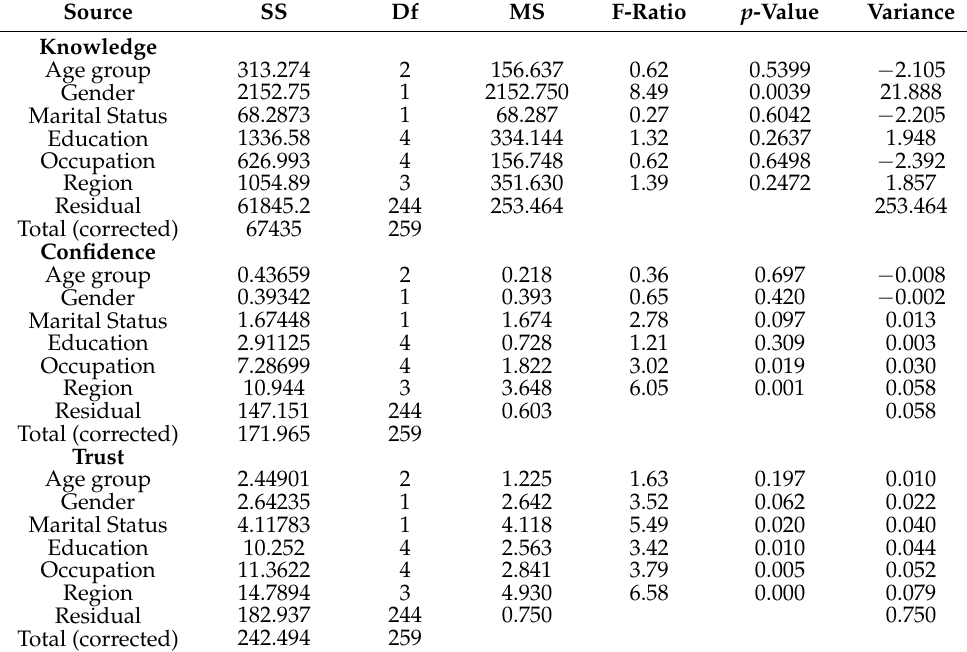
Table 5. Regression model outcome summary and significance of predictor